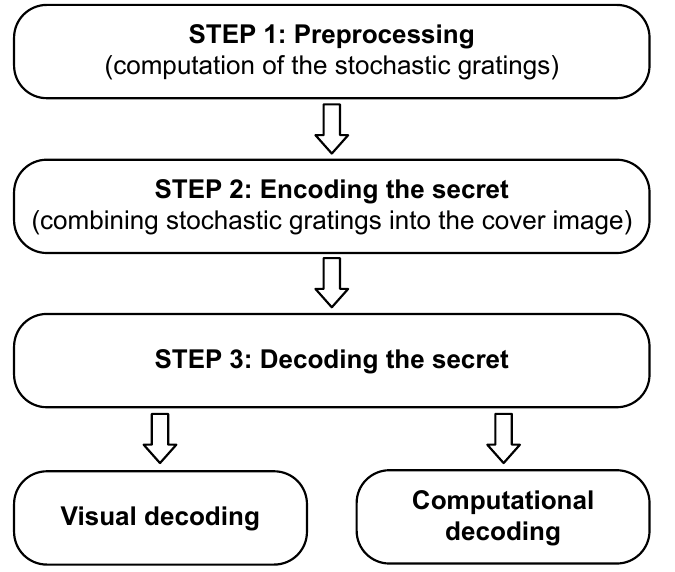
Figure 6. The main steps of the proposed